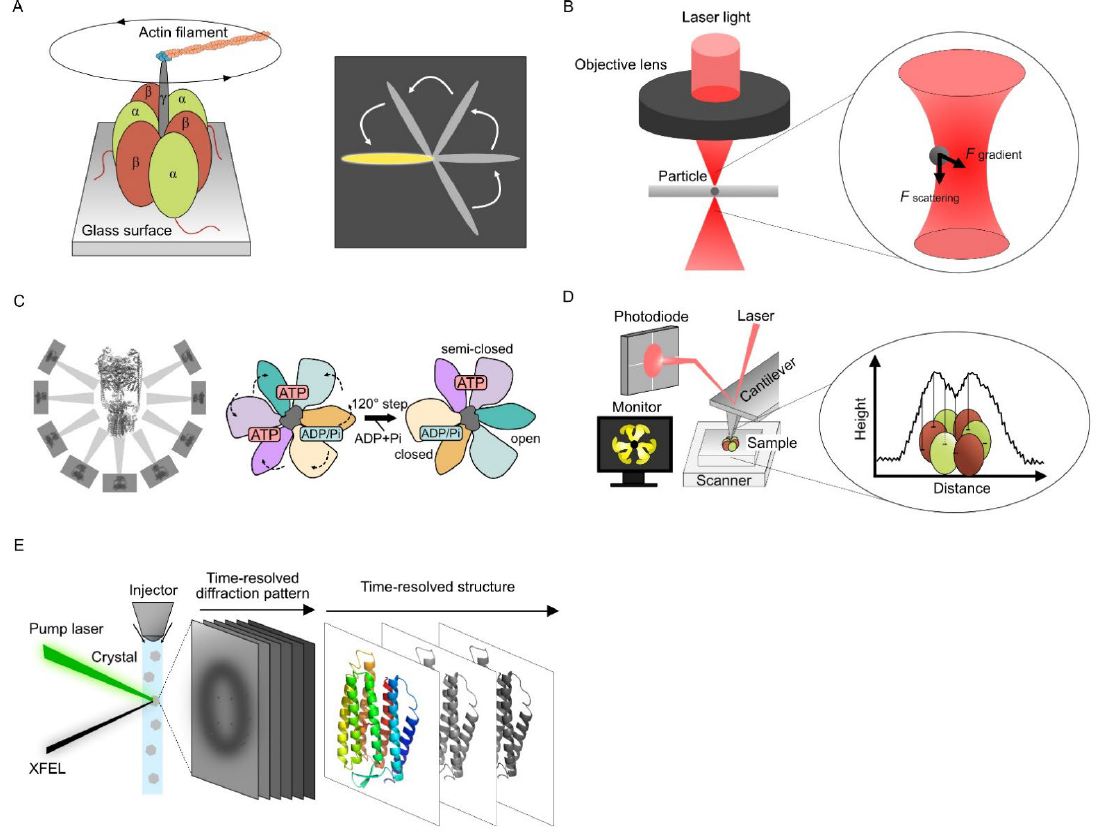
Figure 1. Membrane protein dynamics visualization techniques. ( A ) Visualizing single molecular dynamics using an optical microscope. The γ subunit of the F 1 stator ring was labeled with a fluorescent actin filament. The anticlockwise rotation of the γ subunit was observed under an epifluorescence microscope [15]. ( B ) OT use a highly focused laser beam to generate force to trap or move a single molecule. This technique can be applied to understand biological mechanisms, such as conformational change, folding mechanisms, and protein-membrane interactions. ( C ) Cryo-EM and the classification technique. Two-dimensional-class averaged images of V-ATPase elucidated the rotational model of V-ATPase. ATP hydrolysis causes a 120 ◦ rotation step and conformation change in each subunit [17]. ( D ) HS-AFM scans the sample surface using the tip attached to the cantilever. The conformational changes of the protein are captured by the movement of a photodiode depending on the height of the protein. ( E ) XFEL imaging and SFX sample loading. Time-resolved X-ray diffraction and conformational changes of a protein are obtained by XFEL irradiation and photoactivation with various intervals (the image of the protein was generated from